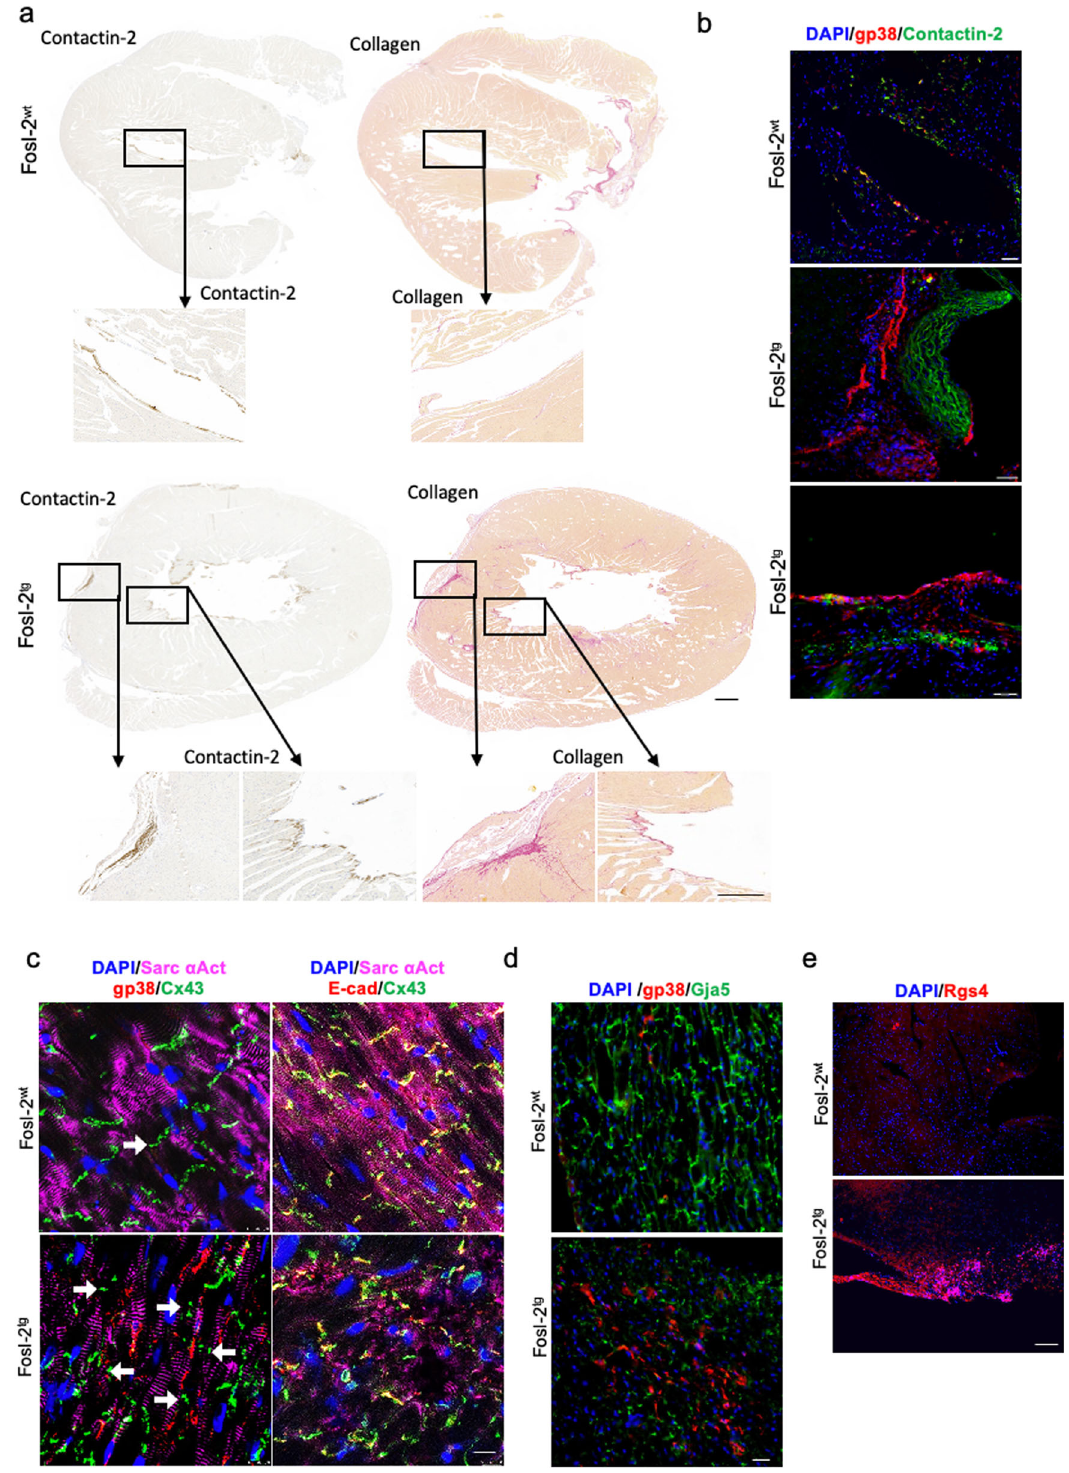
Fig. 4 Alteration in the gap-junction and association of cardiac conduction system with fi brosis in Fosl-2 tg mice. a Representative pictures of contactin- 2 IHC and Sirius Red staining in the myocardial sections from 16 to 22-week-old Fosl-2 wt and Fosl-2 tg mice ( n = 6). Scale bar: 500 µ m, insert scale bar: 50 µ m. b Representative pictures of contactin-2 (green) and gp38 (red) immuno fl uorescence counterstained for nuclei with DAPI (blue) in the myocardial sections from 16 to 22-week-old Fosl-2 wt and Fosl-2 tg mice ( n = 6). Scale bars: 100 µ m. c Representative pictures of connexin-43 (Cx43, green) or E-cadherin (red), gp38 (red) and sacromeric α -actinin (Sarc α Act, pink) immuno fl uorescence counterstained for nuclei with DAPI (blue) in the myocardial sections from 16 – 22-week-old Fosl-2 wt and Fosl-2 tg mice ( n = 6). Scale bars: 50 µ m. d Representative pictures of connexin-40 (Gja5, green) and gp38 (red) immuno fl uorescence counterstained for nuclei with DAPI (blue) in the myocardial sections from 16 to 22-week-old Fosl-2 wt and Fosl-2 tg mice ( n = 6). Scale bars: 50 µ m. e Representative pictures of Rgs4 (red) immuno fl uorescence counterstained for nuclei with DAPI (blue) in the myocardial sections from 16 to 22-week-old Fosl-2 wt and Fosl-2 tg mice ( n = 4). Scale bars: 50 µ